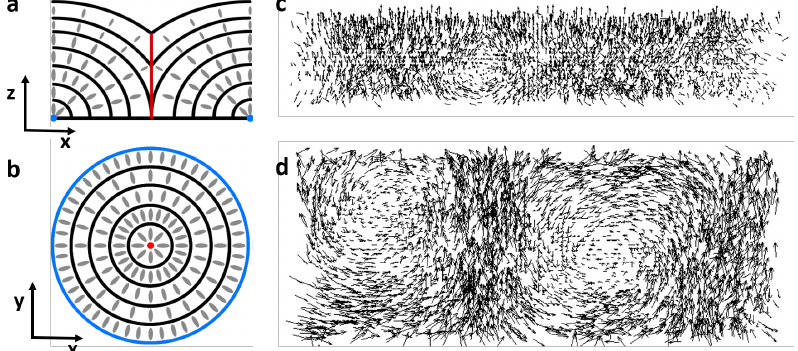
Figure 1. Circular domains in smectic and cholesteric liquid crystals (LCs). ( a , b ) Schematic of toric focal conic domains (FCDs), side view ( a ) and top view ( b ). The schematic highlights the smectic layers and the LC molecular arrangement. The central defect line is shown in red and the singular points at the edge of the defect are shown in blue. ( c , d ) Simulations of circular cholesteric domains, side view ( c ) and top view ( d ). The glyphs indicate the molecular arrangement. Computer simulations were performed minimizing the Landau–deGennes free energy [24] of chiral LCs confined in a channel with one homeotropic wall and three planar